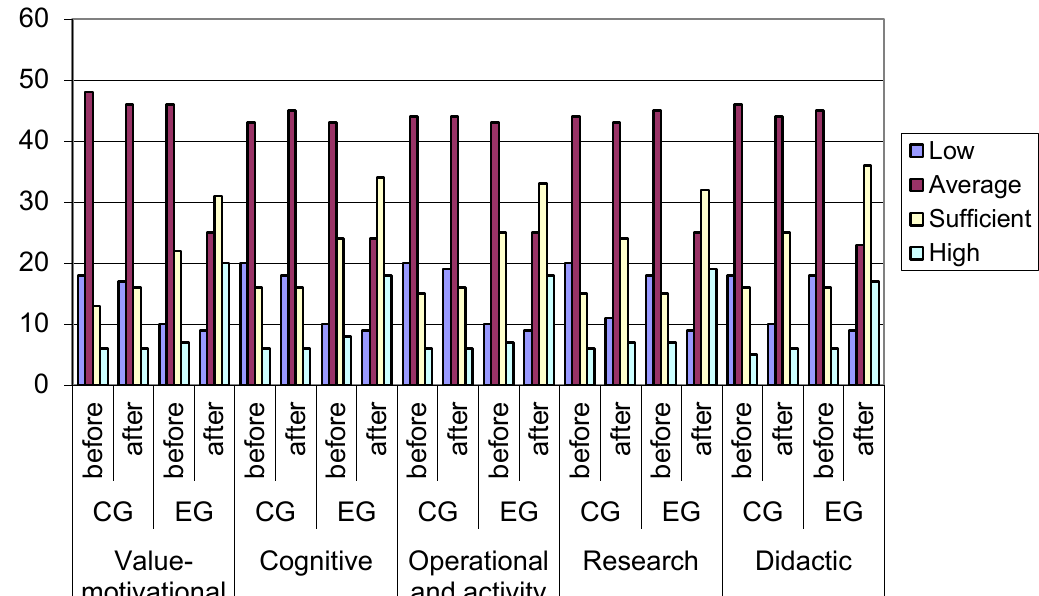
Figure 3: Comparative distribution of students according to the levels of formation of digital competence of CS bachelors in the use of CBLE in control (CG) and experimental (EG) groups (before and after the